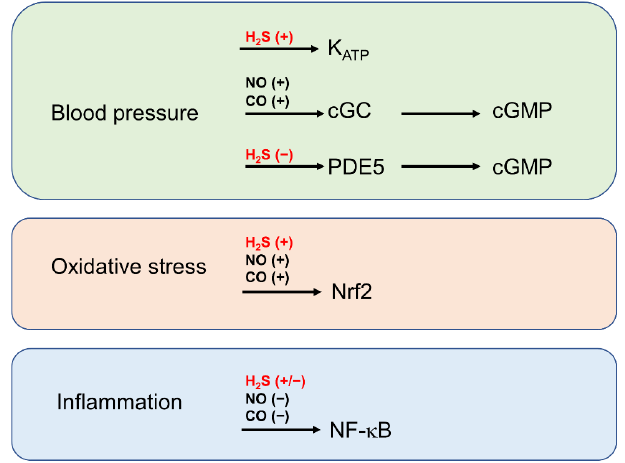
Figure 5. Possible effects of H 2 S on the classical symptoms of glomerular disease in comparison to other gasotransmitters. Gasotransmitters exert similar effects on blood pressure, oxidative stress and inflammation. Note that different effects of H 2 S-mediated S-transulfuration on NF- κ B have been reported [64,65]. In contrast to NO and CO, H 2 S elevates cGMP levels not by activation of sGC, but by inhibition of PDE5. PDE5, phosphodiesterase 5; sGC, soluble guanylyl cyclase; cGMP, Cyclic guanosine monophosphate.